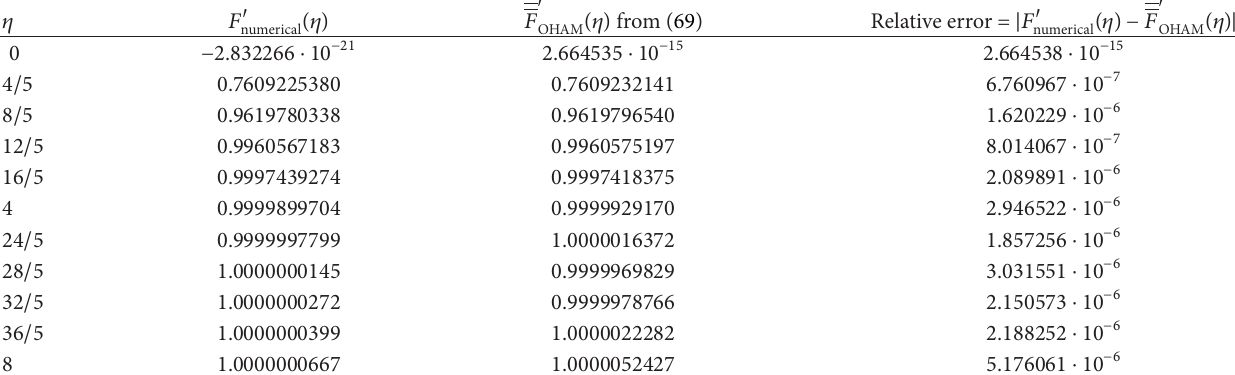
Table 24: Comparison between OHAM results for velocity 𝐹